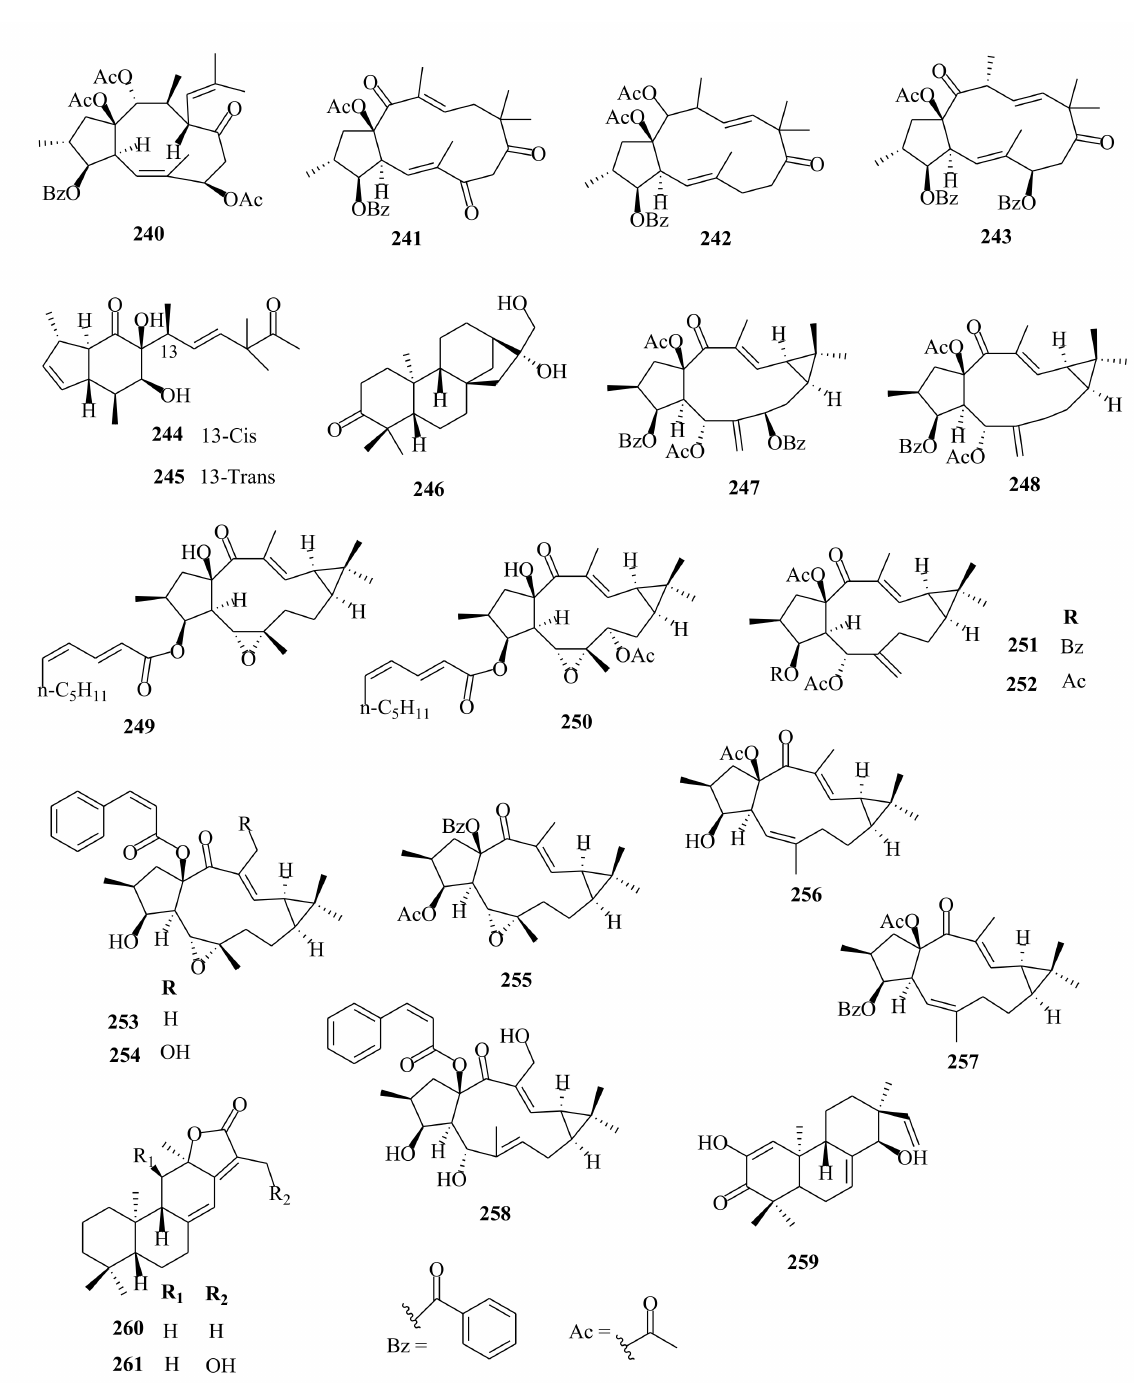
Figure 10. Continued: Chemical structures of Euphorbia jatrophane